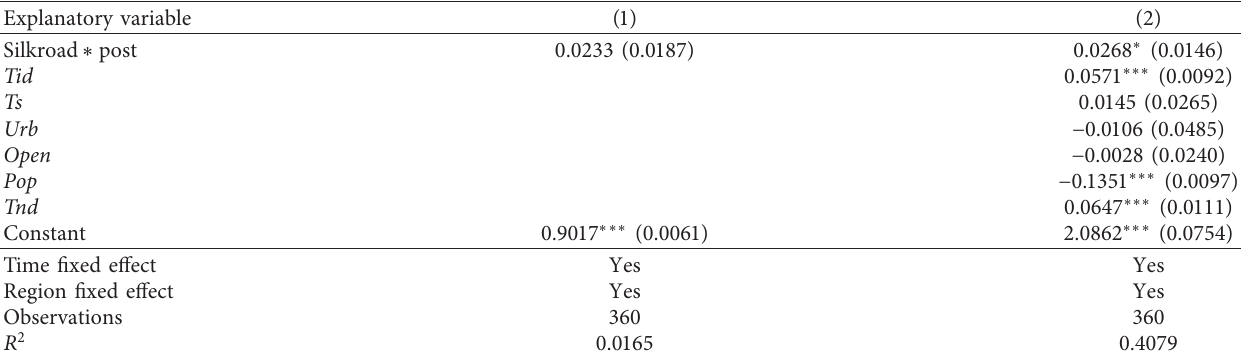
Table 4: Effects of the Belt and Road Initiative on the unified economic and environmental efficiency of transportation infrastructure. Explanatory